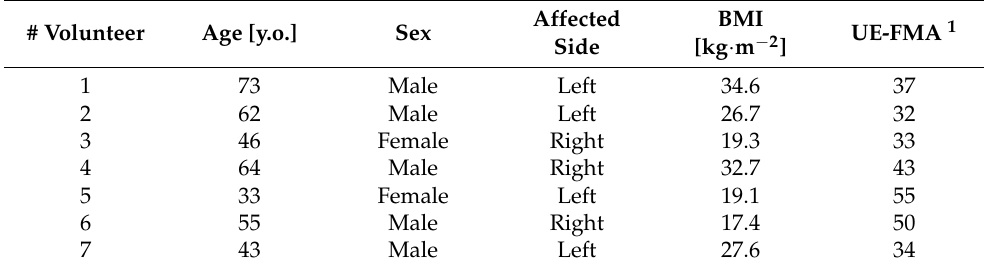
Table 1. Features of the enrolled hemiplegic